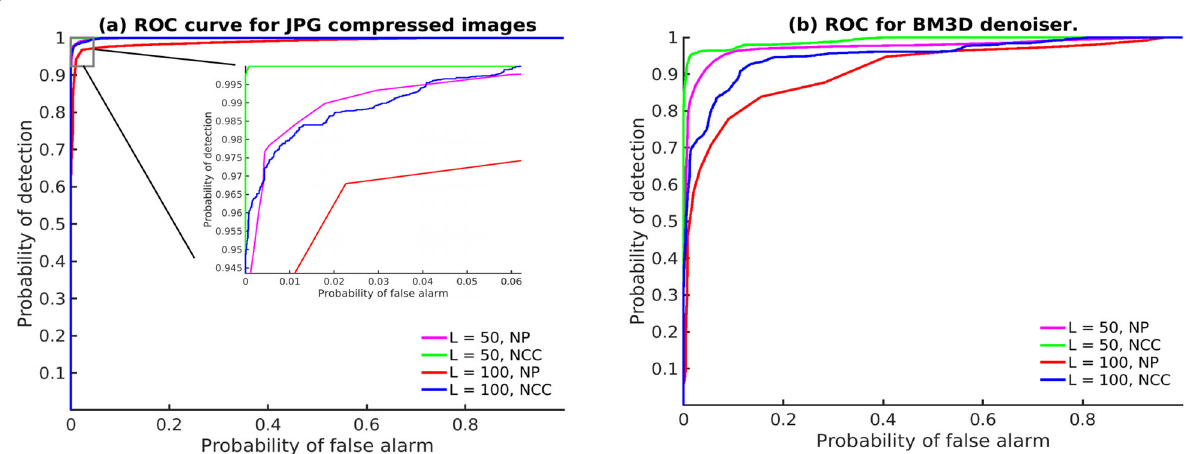
Fig. 7 Receiver operating characteristic for the NP detector and the NCC, for L = 100 and L = 50. (Left) Results for the wavelet denoiser, using JPEG compressed images with a Quality Factor of 92, for the camera Nikon D7000. The results indicate that both the NP and the NCC detectors provide a similar detection performance. (Right) Results for BM3D denoiser, for TIFF images obtained from the Nikon D7000. As we can see, the performance of the detectors decreases with respect to the wavelet denoiser, but the test is still able to obtain an acceptable degree of discrimination, showing that the leakage is still present in the